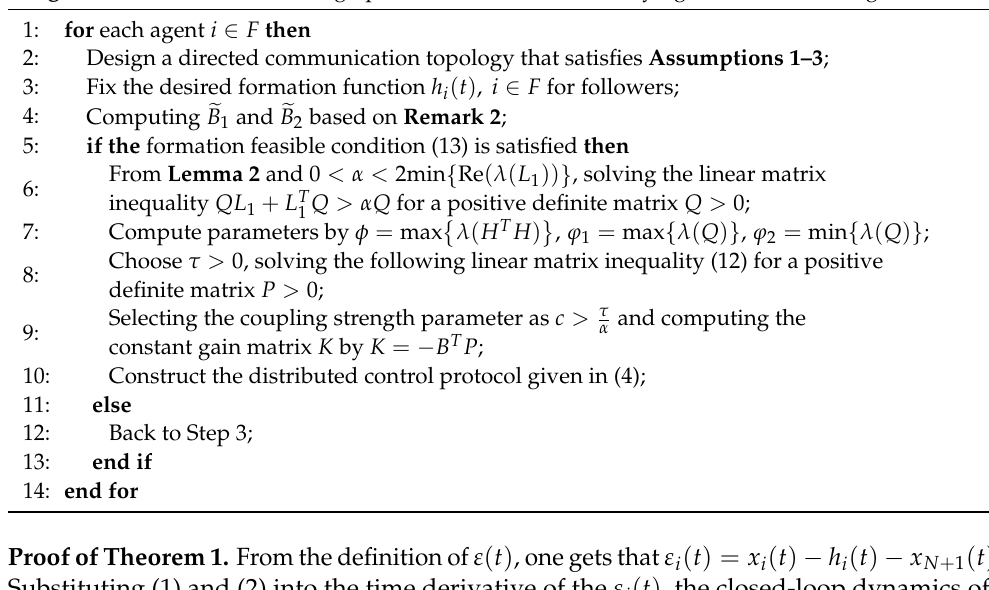
Algorithm 1 Procedures to design parameters for H ∞ time-varying formation